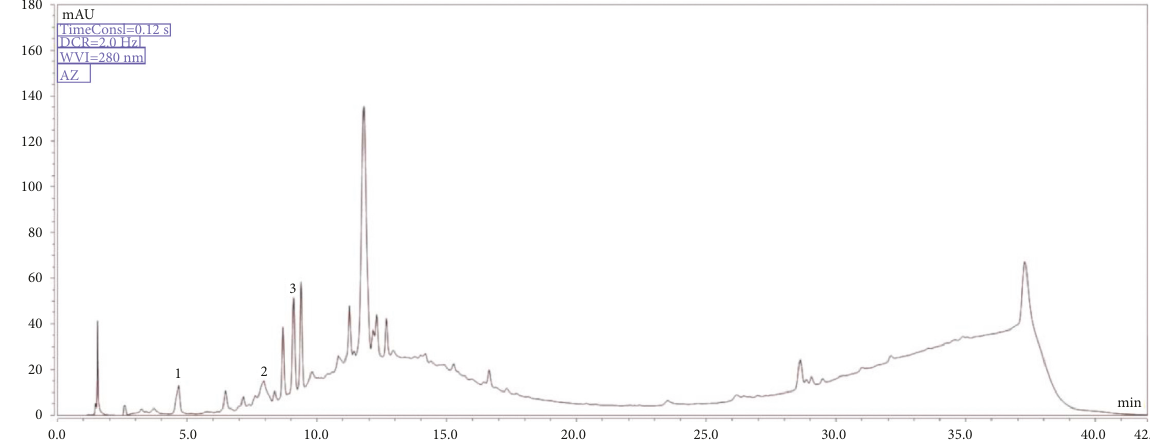
Figure 2: Chromatogram of formulation EV5 (1 � gallic Acid; 2 � catechin; 3 �